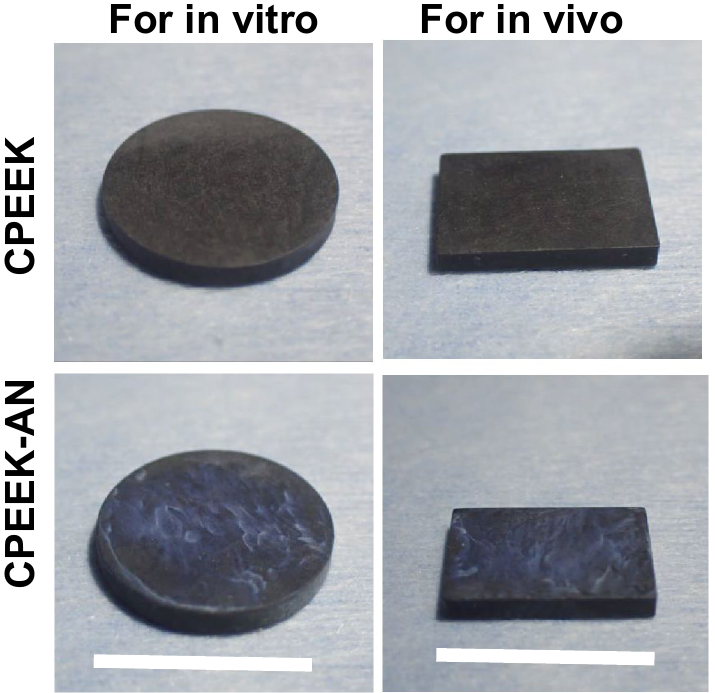
Figure 1. Photographs of the substrates (CPEEK, CPEEK-AN) for in vivo and in vitro study. White bar indicates 15